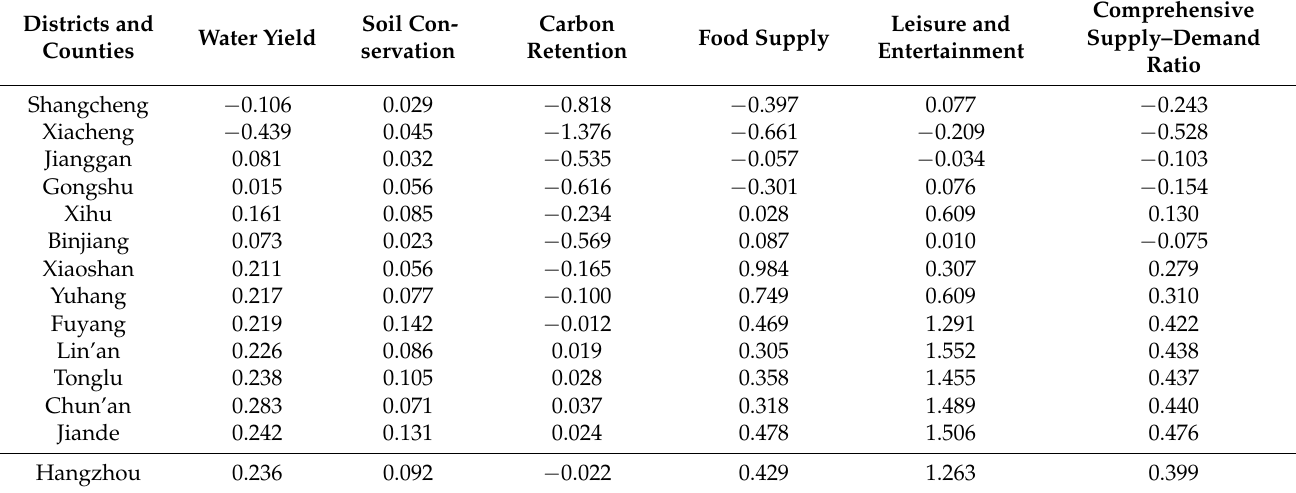
Table 2. ESDR in each district and county of